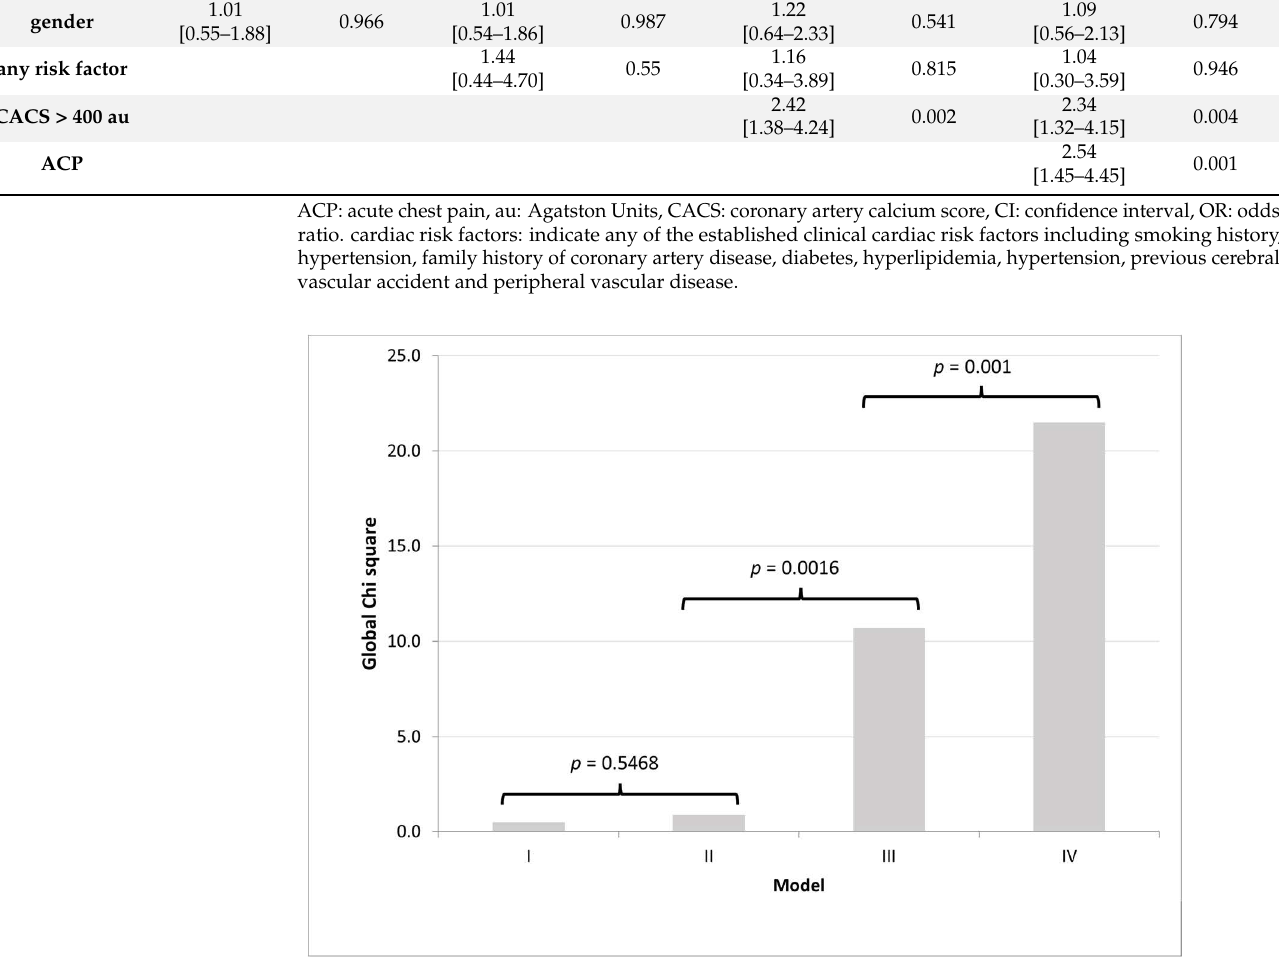
Figure 3. The incremental value of clinical setting (ACP) over clinical risk factors and CACS > 400 au resulted in significant increase in the global chi square. Among patients with a high CACS, the clinical setting adds significantly to the prediction of severe CAD. ACP: acute chest pain, au: Agatston Units, CACS: coronary artery calcium score, CAD: coronary artery disease. Model I: age + gender, Model II: age + gender + cardiac risk factors, Model III: age + gender + cardiac risk factors + CACS > 400 au, Model IV: age + gender + cardiac risk factors + CACS > 400 au + ACP. cardiac risk factors: indicate any of the established clinical cardiac risk factors including smoking history, hy- pertension, family history of coronary artery disease, diabetes, hyperlipidemia, hypertension, pre- vious cerebral vascular accident and peripheral vascular disease.